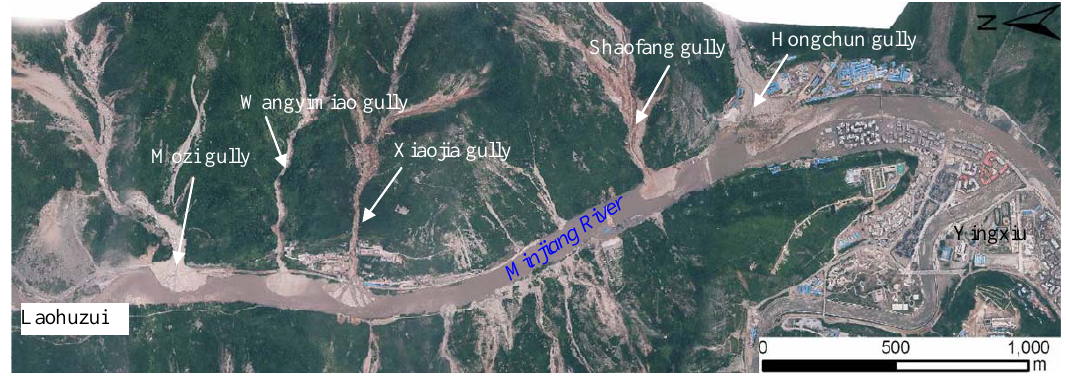
Fig. 17. Aerial photograph of the 8.13 debris flows between Yingxiu Town and Laohuzui along the Minjiang River (provided by the Sichuan geological environmental monitoring station). Fig. 19. An overview of the Wenjia gully debris flow and the remedial works.